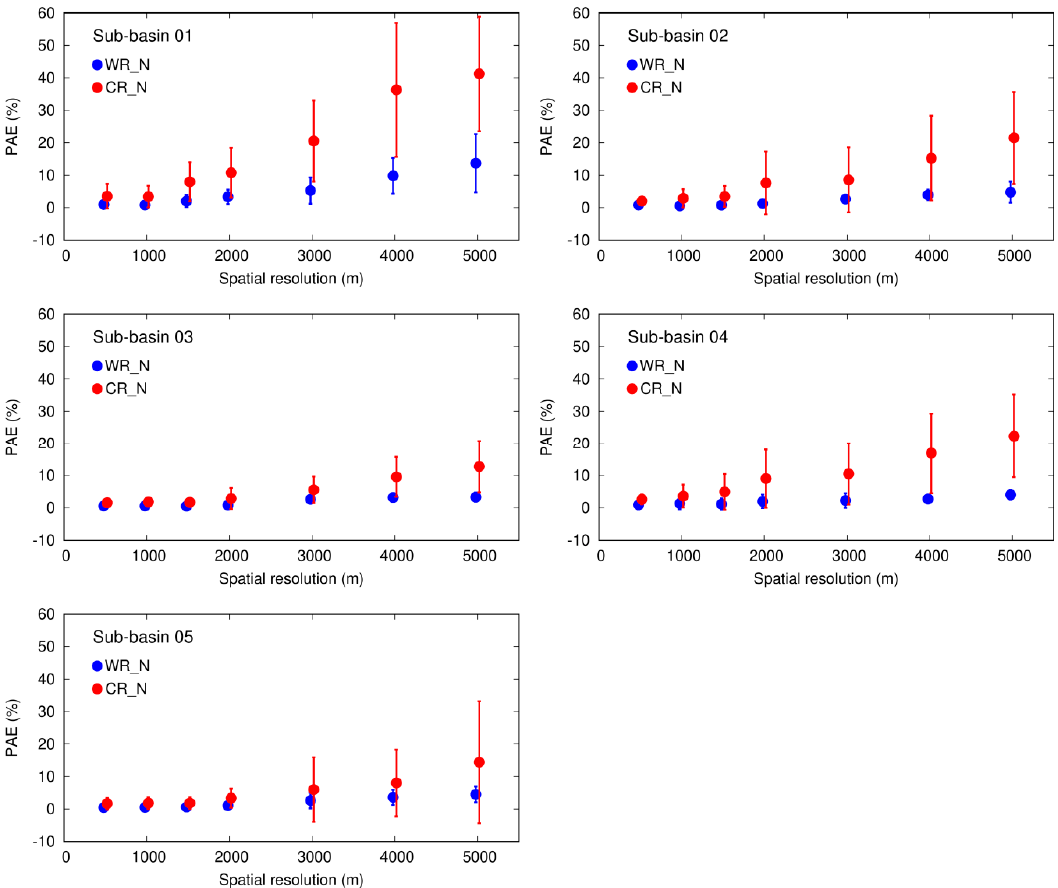
Figure 12. Percent absolute error profile with the standard deviation (vertical error bar) of the simulated discharge at each sub-basin using different rainfall data spatial resolutions (WR_N: widespread rain (WR) cases; CR_N: convective rain (CR) cases).